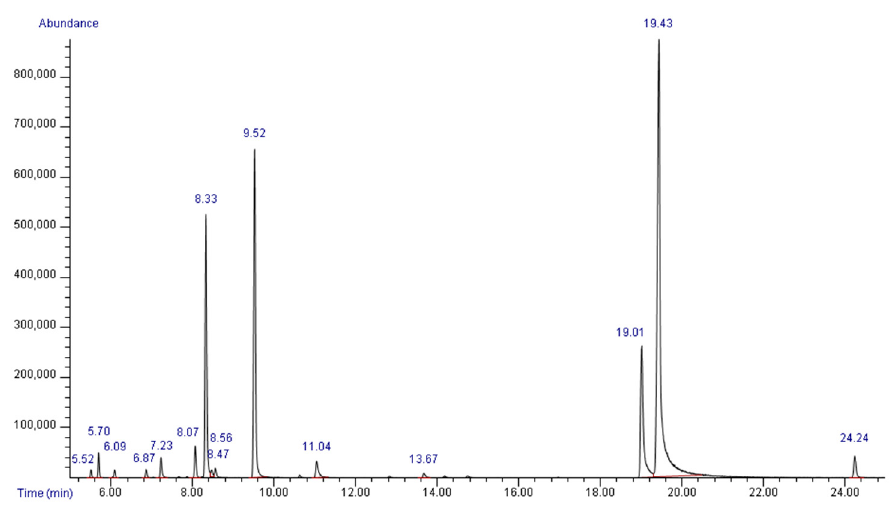
Figure 1. GC-MS chromatogram of HerbELICO ® essential oil